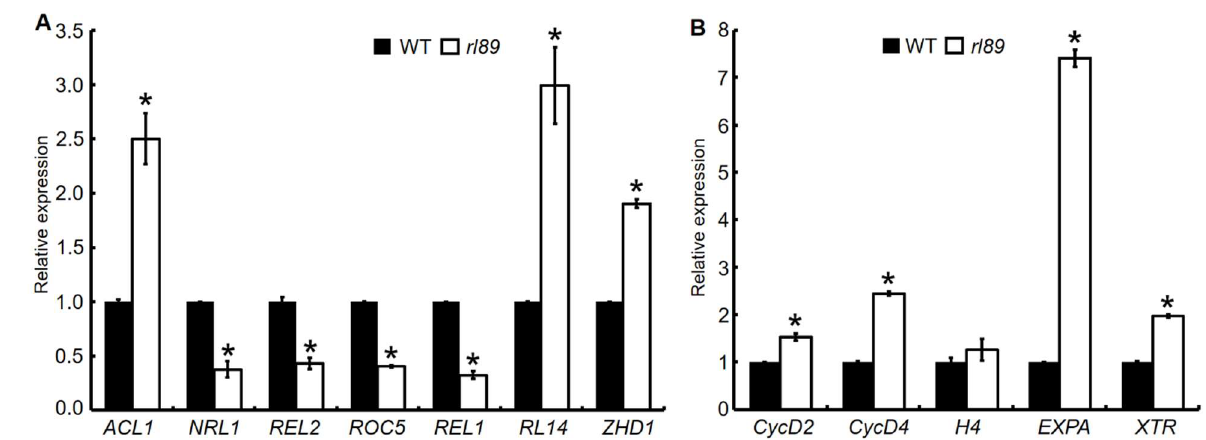
Figure 9. Expression analyses of some genes associated with leaf shape and cell growth. Comparison of expression levels of leaf shape-related genes ( A ) and cell growth-related genes ( B ) were performed between rl89 and the wild type (WT). The total RNA was extracted from the 12th leaves (64 d after sowing, the leaf blades were just fully expanded) of rl89 and WT, respectively. The relative mRNA amount of each gene was normalized to OsActin . The relative expression of each gene in WT was set to 1.0, and those in rl89 were calculated accordingly. Error bars represent the SDs of three independent experiments. Asterisks indicate statistically significant differences compared with the wild type at p < 0.05.